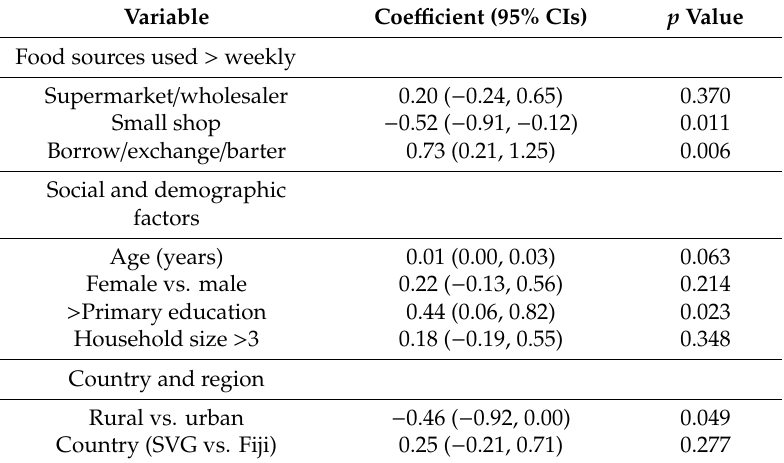
Table 8. Factors associated with the dietary diversity score (DDS) in the CFaH project. Results of multiple linear regression with all independent variables entered together and adjustment for household